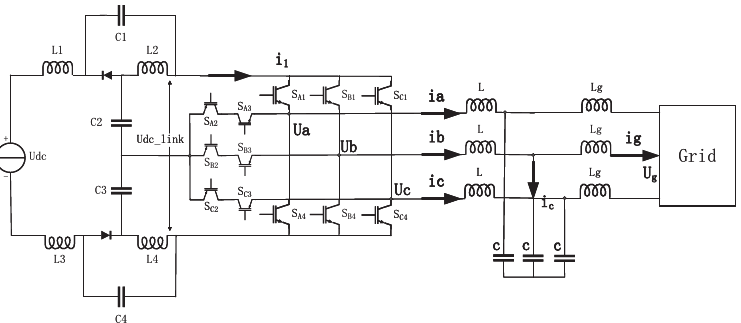
Figure 1. The structure of the quasi-Z-source three-level inverter with LCL filter. The switch states of the quasi-Z-source three-level inverter are listed in Table 1. In Table 1, P, O, and N represent three levels of non-shoot-through state, and F represents the up-shoot-through status. Table 1. Switching state and output voltage (X = A, B, or C). State of Operation Turn-On Switchs